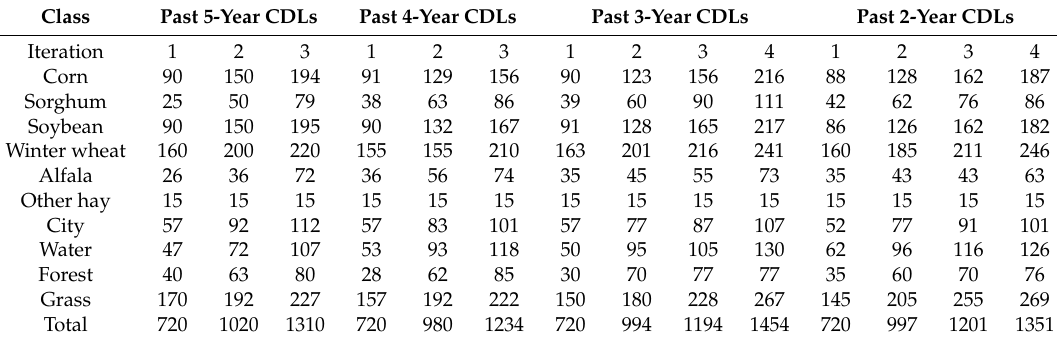
Table 4. Number of new training data at each iteration for four different past CDL combination